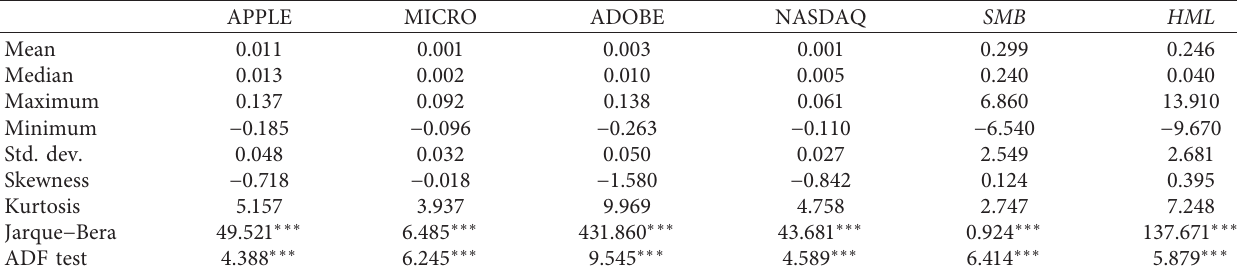
Table 7: Descriptive